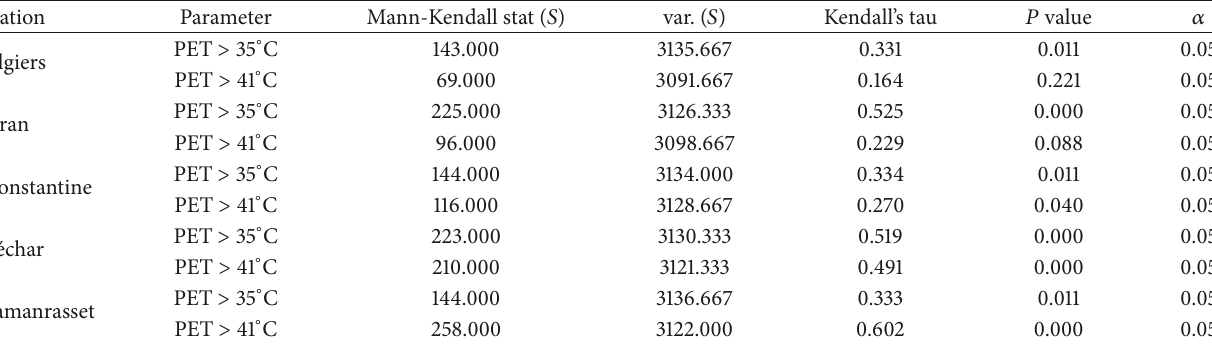
Table 3: Annual occurrence evolution of hot (PET > 35 ∘ C) and very hot (PET > 41 ∘ C) days. Mann-Kendall’s trend test results.